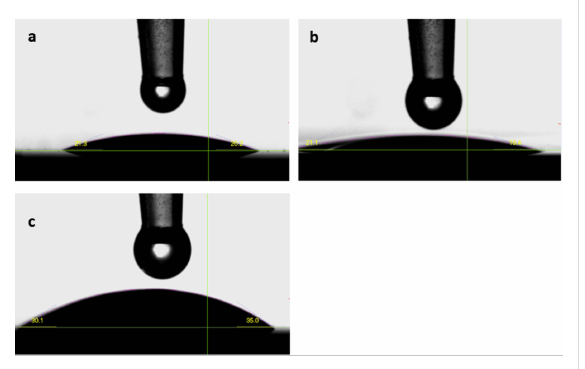
Figure 6: Contact angle between water and films made of TTIP and (a) thymine (b) uracil and (c)